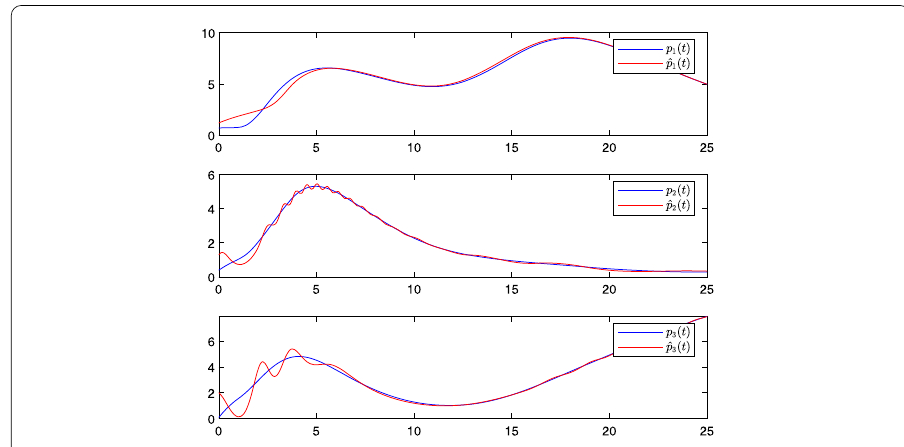
Figure 10 Synchronization behavior between proteins p i ( t ) and ˆ p ( t ), i = 1,2,3